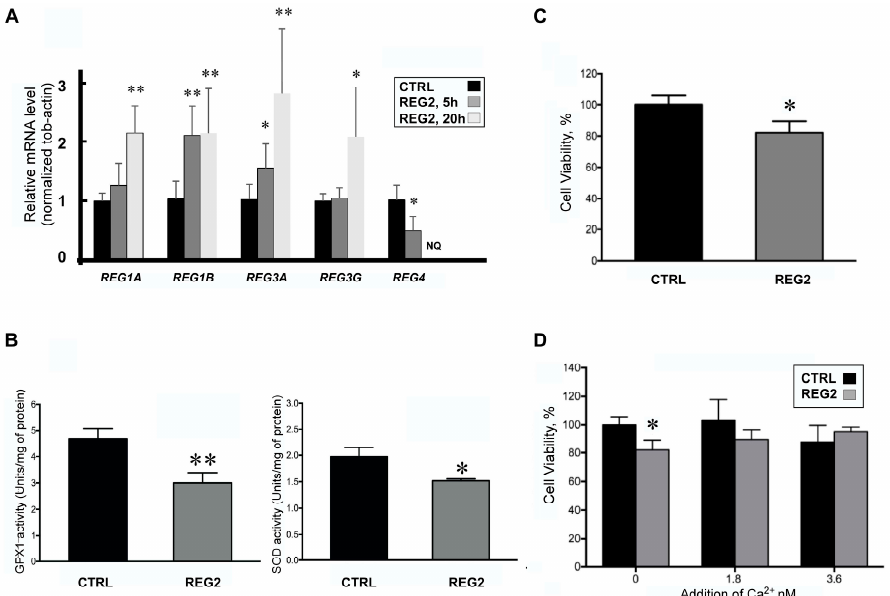
Figure 4. Effects of treating human PANC1 (cancer) cells with murine REG2 protein on mRNA levels of 5 human REG genes [( A ), after 5 and 20 h of treatment], GPX1 and SOD activities [( B ), after 20 h of treatment], cell viability [( C ), after 20 h of treatment], and cell viability at three doses of additional calcium ions [( D ), after 20 h of treatment]. Columns with * or ** differ significantly at p < 0.05 or p < 0.01 from control, respectively. Data were analyzed using Student’s t test within each REG gene ( A ) or calcium concentration ( D ).